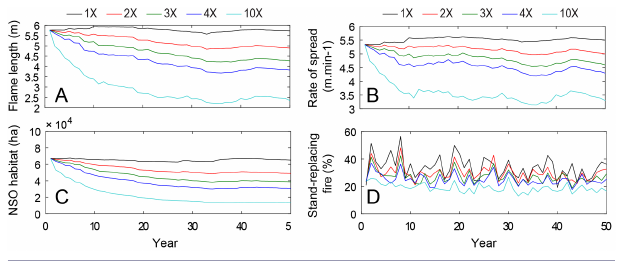
Fig. 8 . Trend in (A) potential flame length, (B) potential rate of spread, (C) northern spotted owl habitat (NSO), and (D) stand- replacing fire by simulation year and wildfire scenario (1X, 2X, 3X, 4X, and 10X). Increased levels of wildfire activity in each scenario were achieved by multiplying the burn period of each ignition over contemporary levels by the multiplier